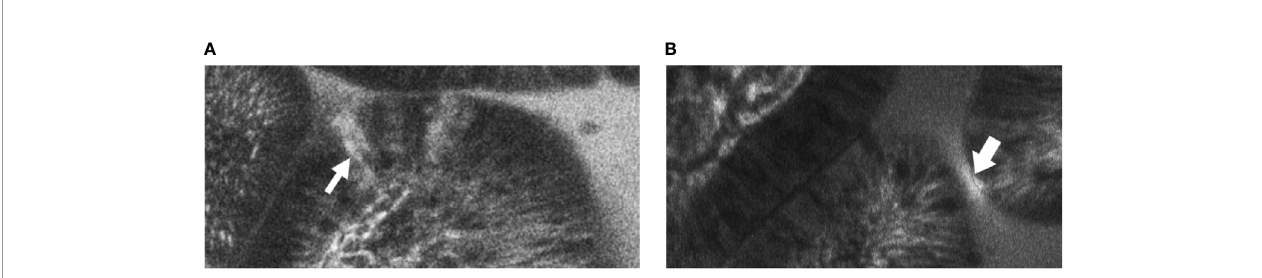
FIGURE 1 | Example images of terminal ileal villi exhibiting (A) fl uorescein leak and (B) cell junction enhancement (A) Cell junction enhancement, characterised by an area of increased fl uorescence from the basal to the apical surface between two epithelial cells. (B) Fluorescein leak, characterised by increased fl uorescence in the epithelial cell layer, and a distinct plume of contrast leakage into the